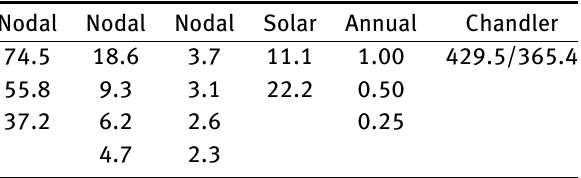
Table 1: Luni-Solar compounded periodicities (yr) modeled in the new kinematic